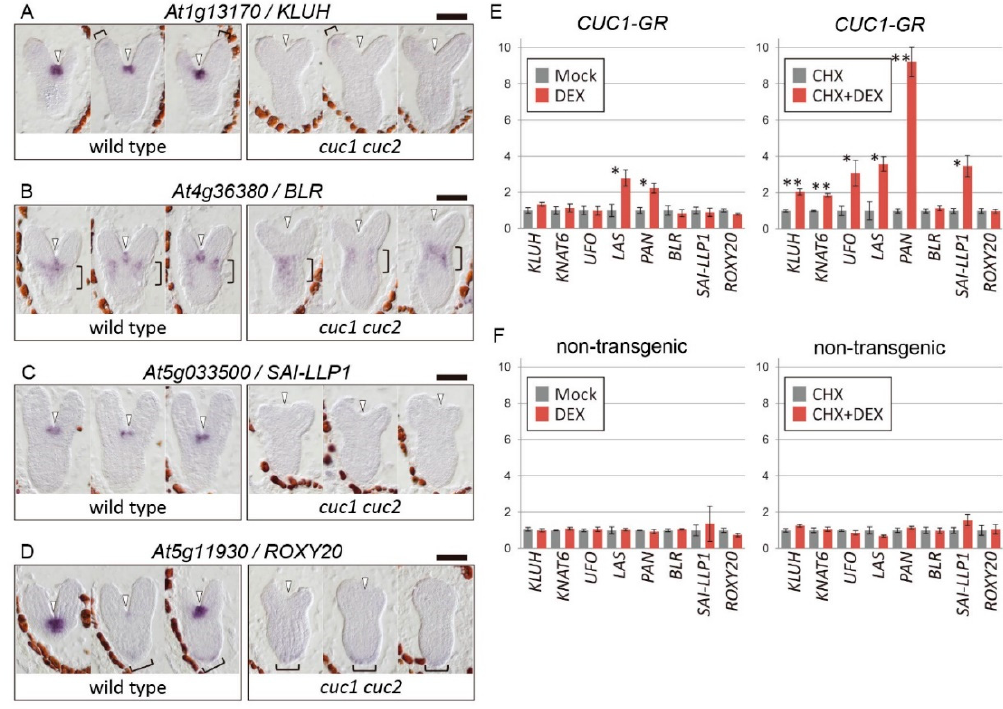
Figure 1. Regulation of candidate downstream genes by CUC1 and CUC2 . ( A – D ) In situ hybridization of newly identified candidate downstream genes. Four of the six candidates are shown. Three serial longitudinal sections of wild-type L er ( left ) and cuc1-1 cuc2-1 double-mutant ( right ) embryos at the late heart stage. Arrowheads indicate the position of the cotyledon boundary region. Brackets in ( A ), ( B ), and ( D ) indicate the position of expression outside the boundary region. Bars = 50 µ m. ( E , F ) Transcriptional responses of candidate downstream genes upon dexamethasone (DEX) treatment in CUC1-GR ( E ) and non-transgenic ( F ) plants in the absence ( left ) or presence ( right ) of the protein synthesis inhibitor cycloheximide (CHX). Three biological replicates of 7-day-old seedlings. Single and double asterisks indicate p < 0.05 and p < 0.01, respectively, in comparisons between samples with and without DEX (Welch’s t ‐ test).